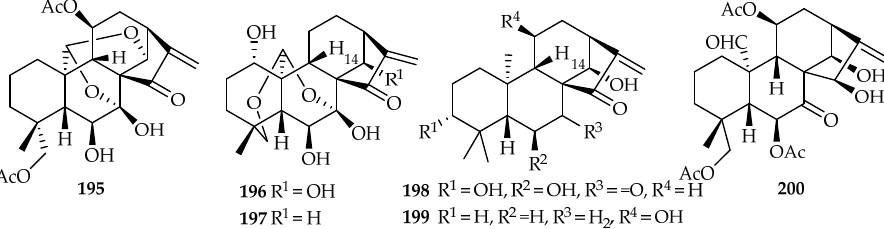
Figure 80. Structures of 19-acetyl xerophilusin A 195 , 1 α -hydroxy xerophilusin D 196 , 1 α -hydroxy- 14-dehydroxy xerophilusin D 197 , pharicusin D 198 , pharicusin E 199 , and pharicusin F 200 [126]. Three new 8,9- seco - ent -kaurane diterpenoids, kongeniods A–C 201 – 203 (Figure 81), were isolated from the aerial parts of Croton kongensis (Euphorbiaceae). Compounds 201 – 203 were evaluated in vitro against the HL-60 and A549 cell lines, with adriamycin as the positive control. Kongeniods A–C 201–203 exhibited strong cytotoxicity against the HL-60 cell line, with IC 50 values of 1.27, 0.47, and 0.58 µ M, respectively; compounds 201 and 202 showed moderate inhibition against the A549 cell line, with IC 50 values of 5.74 and 3.24 µ M, respectively [127].